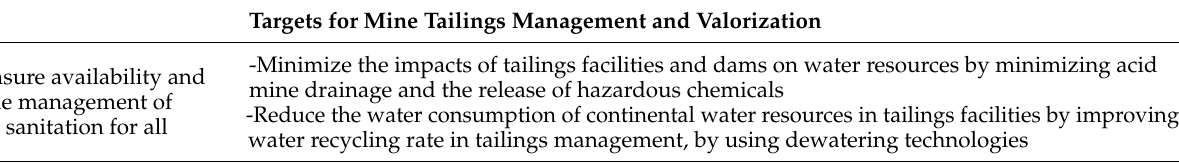
Table 1. Targets for mine tailings management for achieving sustainable development